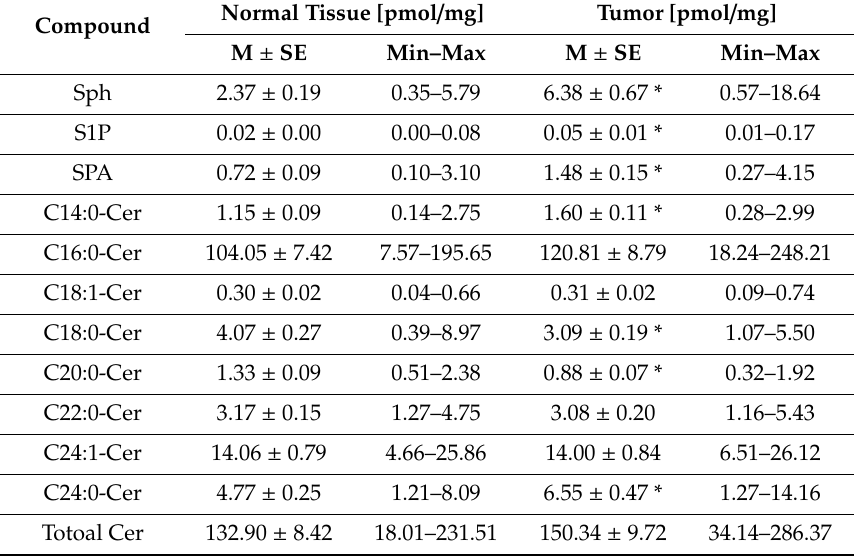
Table 2. Content of sphingolipids in normal colorectal tissue and colorectal cancer tissue. Statistical significance is marked with an